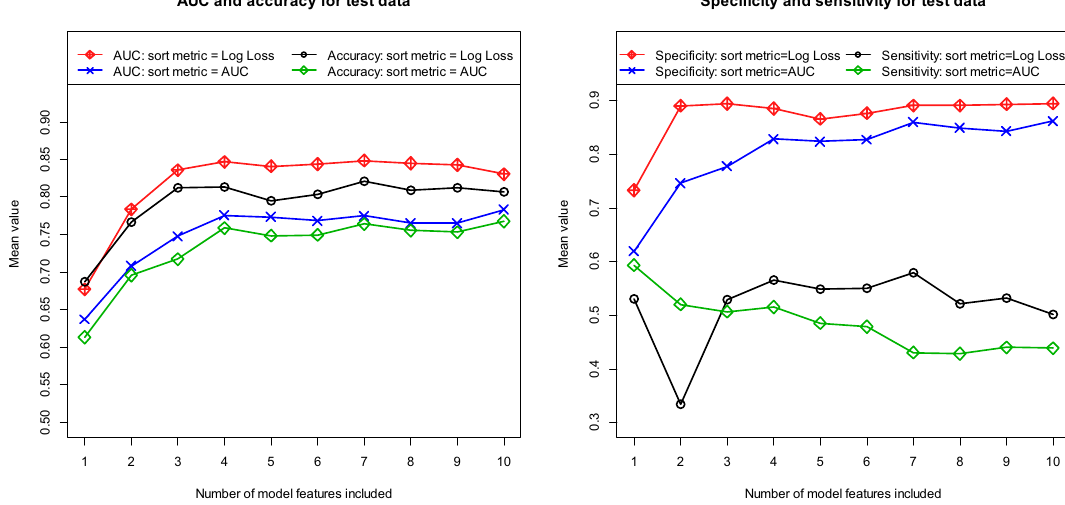
Figure 3. Performance results for models built with Automated Machine Learning (AutoML). Left figure: Area Under the Curve (AUC) and accuracy. Right figure: specificity and sensitivity. All values calculated as means of 100 repetitions (100 cycles) using independent test data. Sort metric used to specify the best model in each cycle: Log Loss (red and black lines) and AUC (blue and green